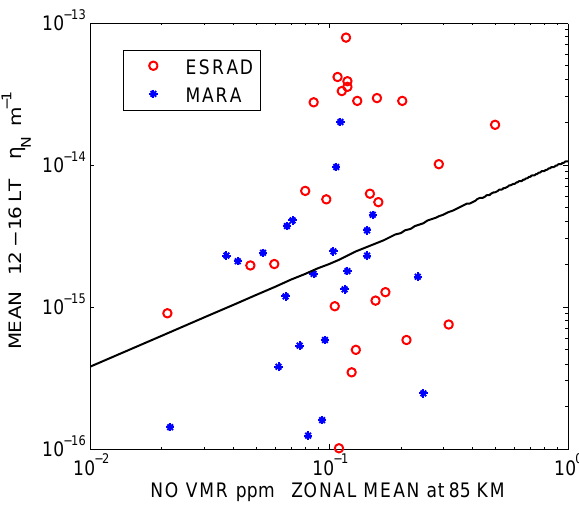
Fig. 11. Mean PMSE volume reflectivity, η N , between 12:00 and 16:00LT as a function of zonal mean NO measured by Odin-SMR on the same day. NO v.m.r. for the geomagnetic latitude band 60– 65 ◦ S is used for MARA, 65–70 ◦ N for